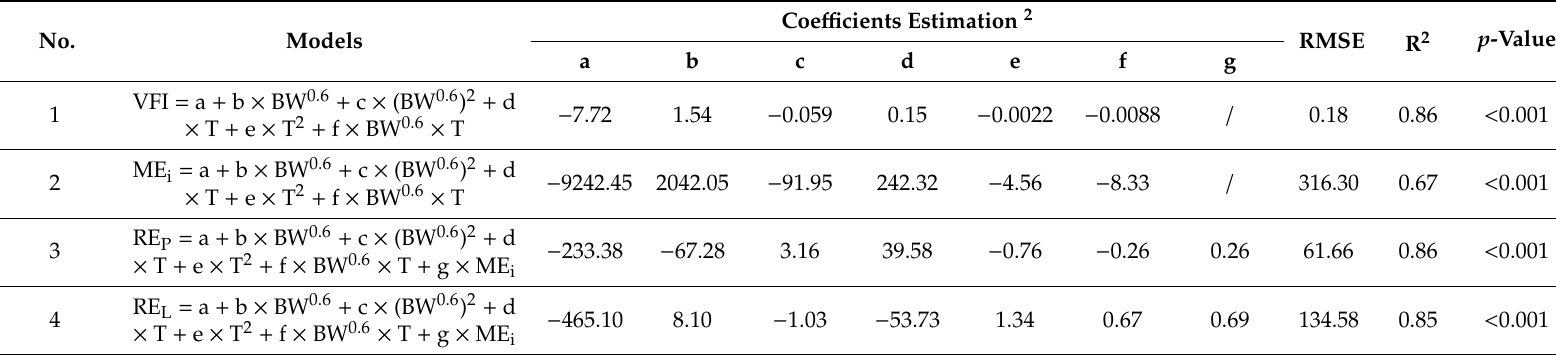
Table 4. Prediction equations for voluntary feed intake, metabolizable energy intake, energy retention as protein, and energy retention as lipid using body weight and ambient temperature as predictors 1